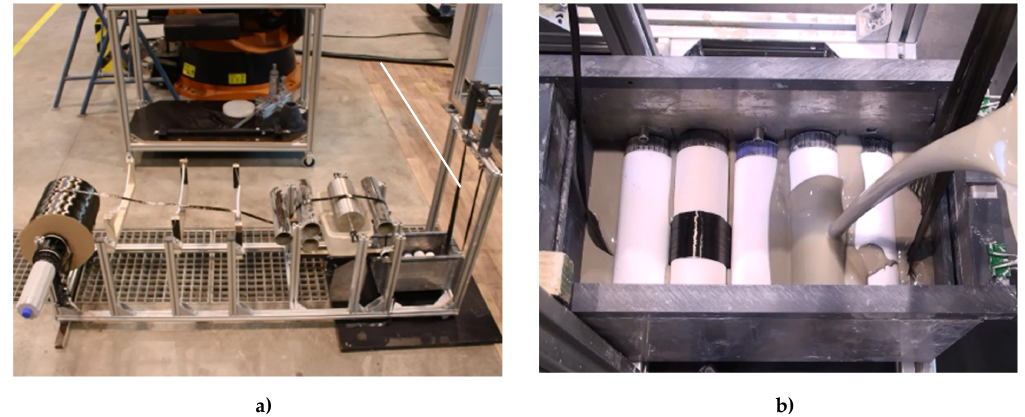
Figure 8 . Fabrication of MCF: a ) entire setup, and b ) five-roller padder used for impregnation Figure 8. Fabrication of MCF: ( a ) entire setup, and ( b ) five-roller padder used for